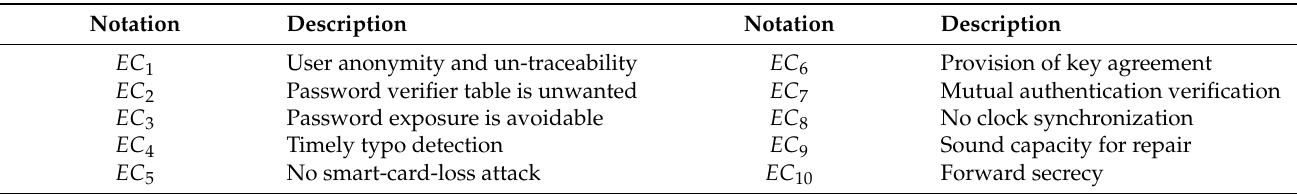
Table 5. Security evaluation criteria for AKA protocols.